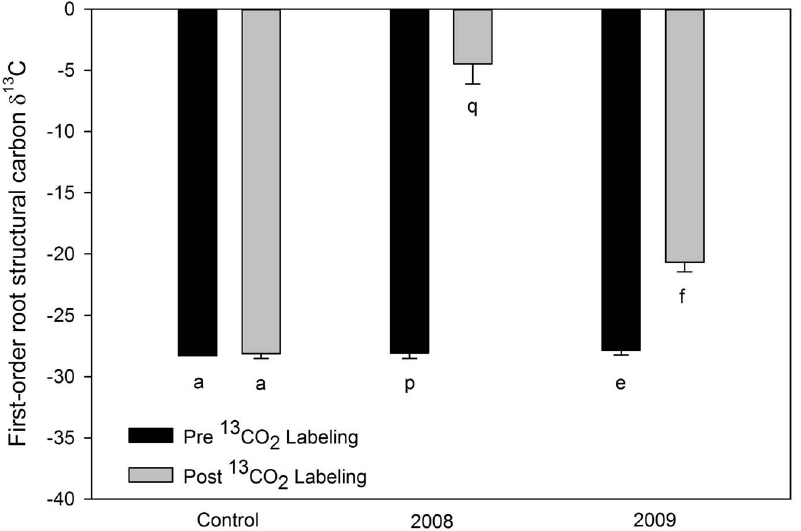
Figure 3. Mean Sassafrasalbidum first-order root structural carbon d 13 C values. Data from an unlabeled control tree, and trees labeled in 2008 and in 2009. All roots were at least 2 weeks old at the time of labeling and subsequent sampling and some were older than 71 days. Black bars represent roots sampled prior to whole-tree labeling and grey bars represent roots sampled after whole-tree labeling. Note that less negative values indicate greater isotopic enrichment. Error bars denote standard error between individual sampled roots. Different lower case letters denote significant differences at P # 0.05 using a one tailed T-test between pre- and post-labeled roots.